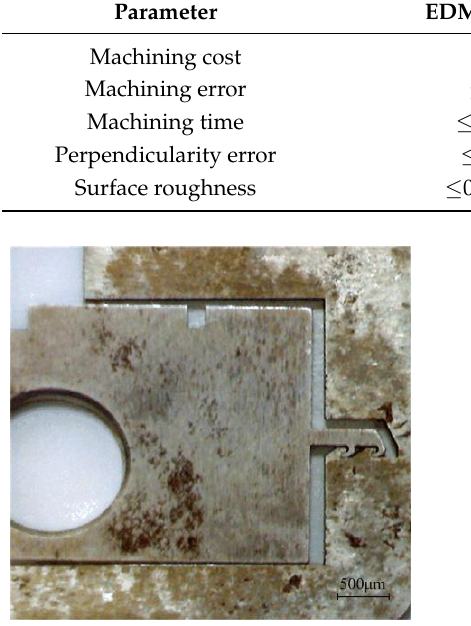
Figure 27. Test results of prototype #10.